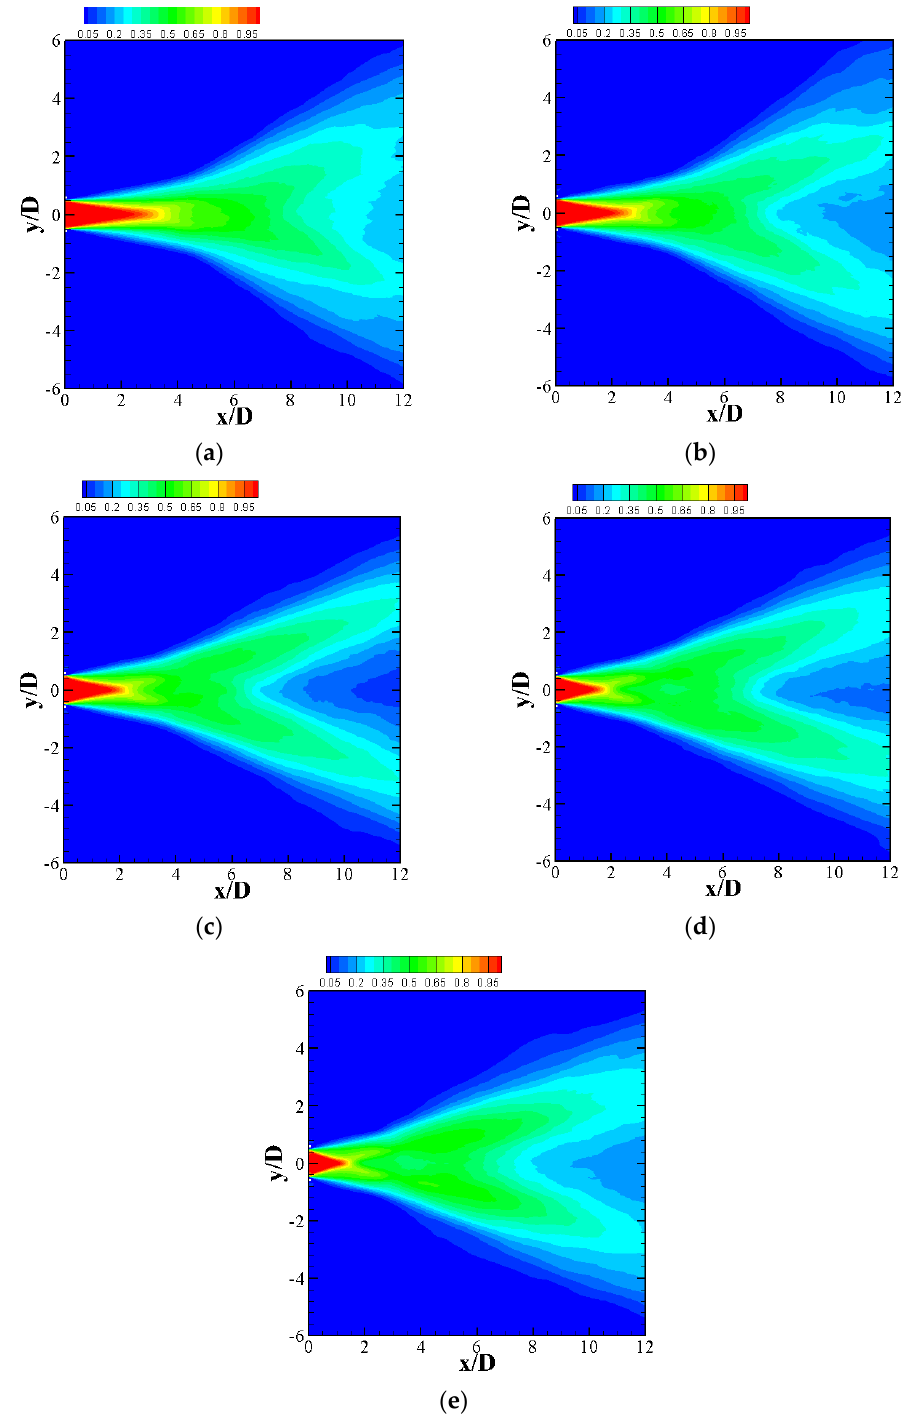
Figure 9. Time-averaged streamwise velocity in the forced plane, normalized by U j . ( a ) MFR = 0.67%, ( b ) MFR = 0.83%, ( c ) MFR = 1%, ( d ) MFR = 1.2%, ( e ) MFR = 1.5%.